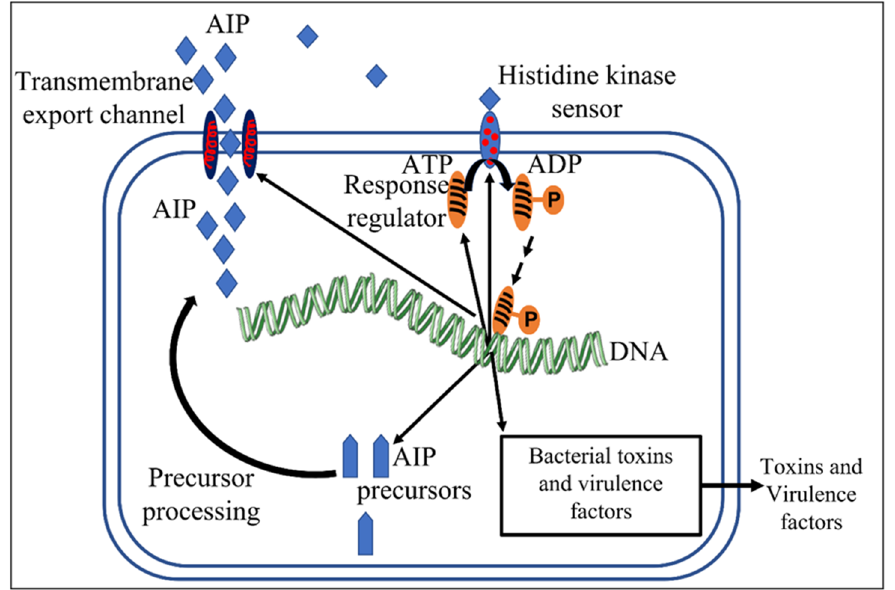
Figure 2. QS in Gram-positive bacteria. AIP (autoinducing peptide) is exported extracellularly, where at increased cell density, enough accumulates to be sensed by the histidine kinase receptor to initiate the transcription of AIP precursors, virulence factors, an export channel, and the regulator and receptor proteins.